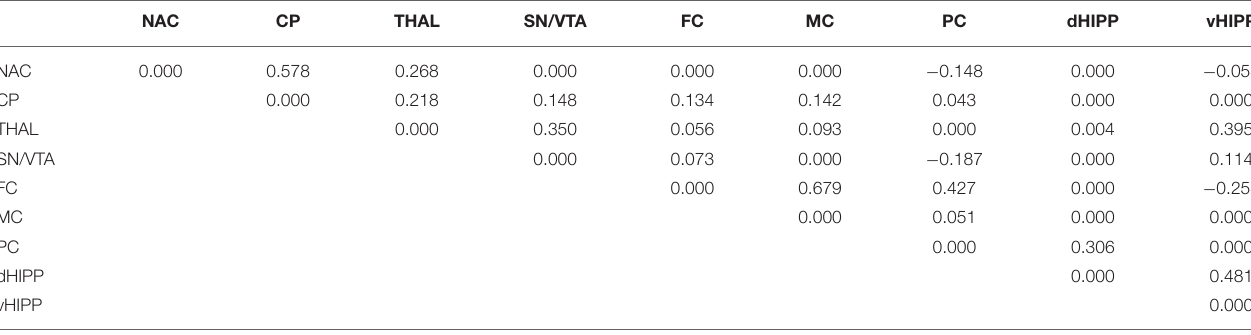
TABLE 1 | Path coefficient matrix after treatment with dimethyl sulfoxide (DMSO) obtained with EBICglasso modeling of D 2 / 3 R binding potentials in nucleus accumbens (NAC), caudate putamen (CP), thalamus (THAL), substantia nigra/ventral tegmental area (SN/VTA), frontal cortex (FC), motor cortex (MC), parietal cortex (PC), dorsal hippocampus (dHIPP), and ventral hippocampus (vHIPP).